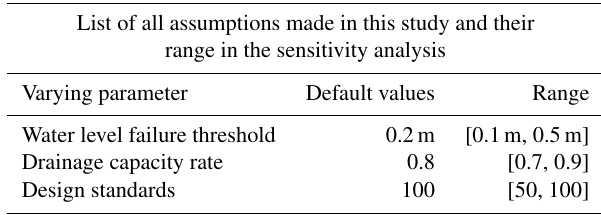
Table A1. List of all assumptions made in this study and their range in the sensitivity analysis. List of all assumptions made in this study and their